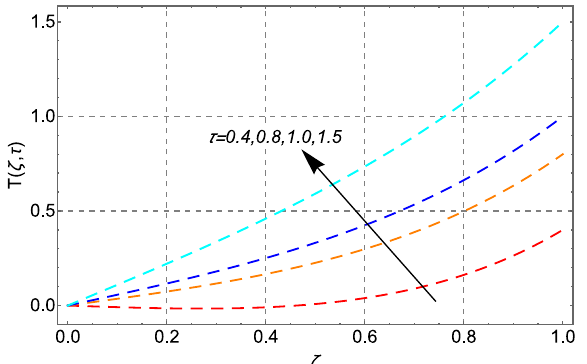
Figure 13. Impact of time parameter τ effect on temperature distribution.